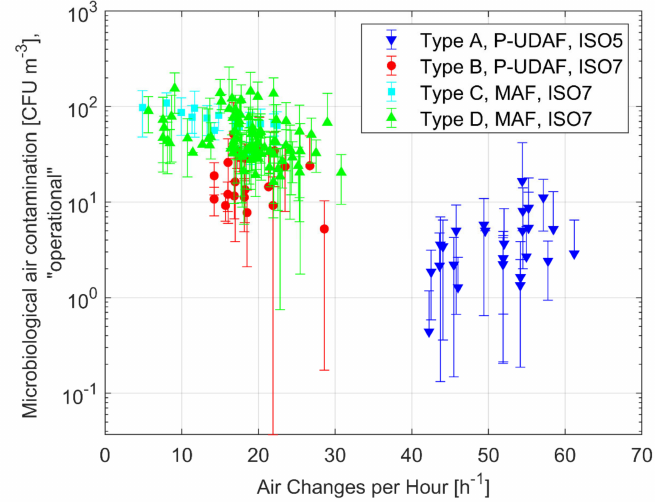
Figure 4. Average microbiological air contamination vs. ACH in “operational” conditions for the 175 investigated